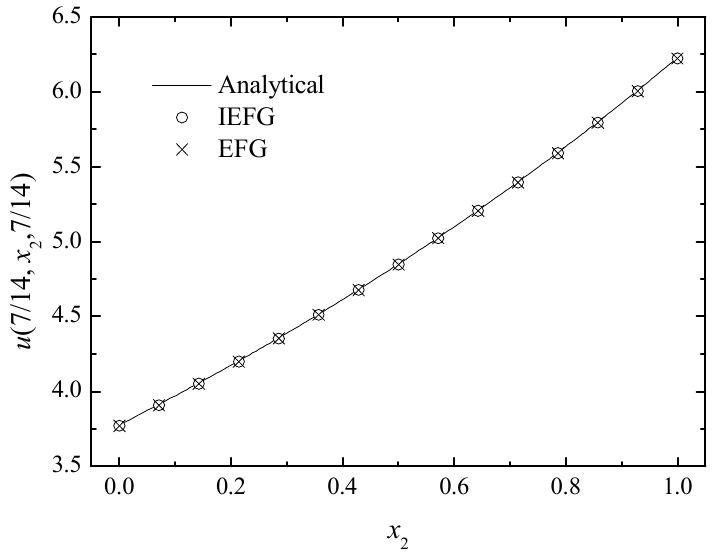
Figure 8. The comparison of the numerical and analytical solutions of the two methods along the x 2 -axis.